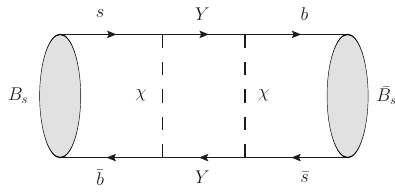
Figure 4. Feynman diagrams of meson mixing involving the invisible